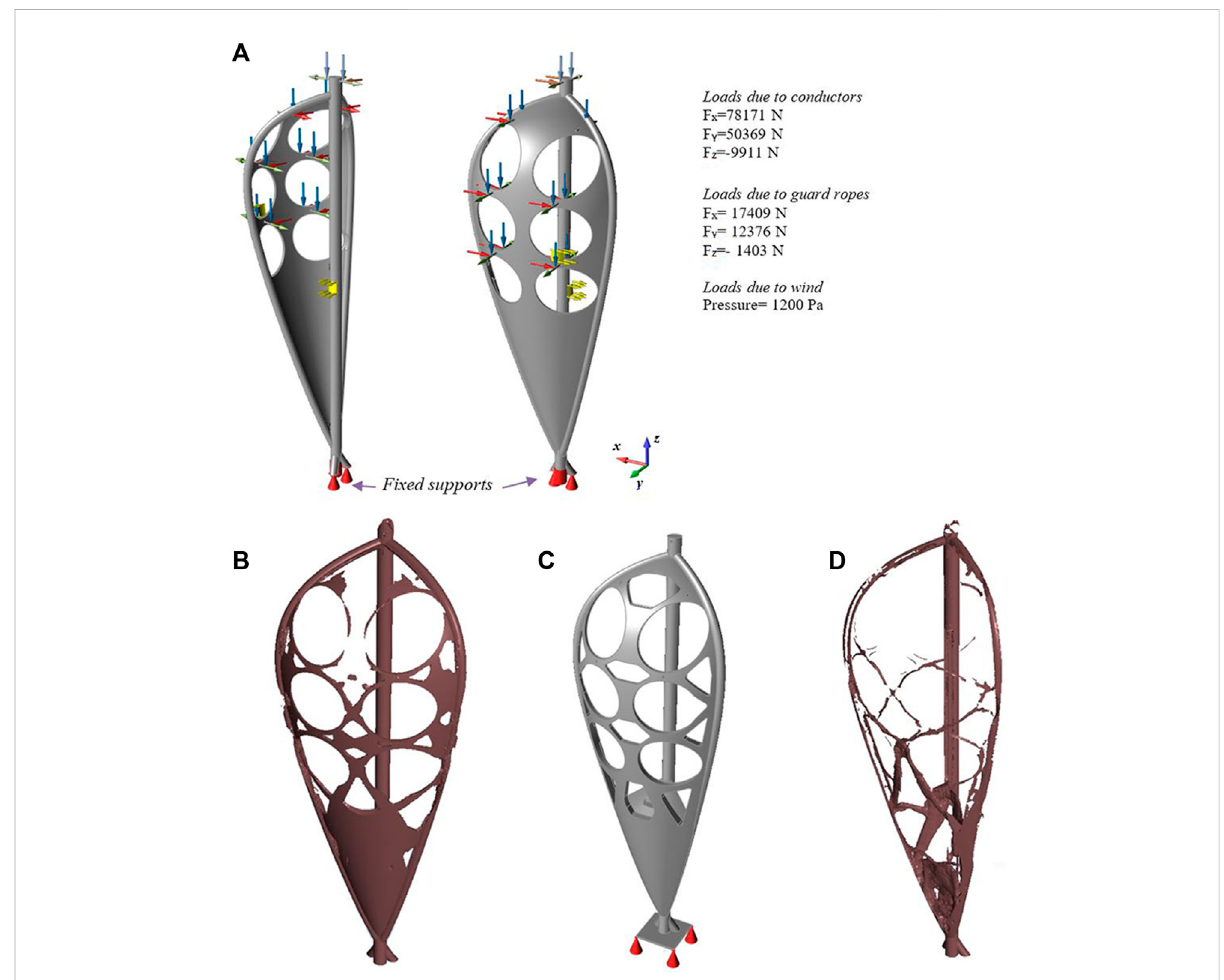
FIGURE 8 TOresults. (A) thegeometricmodel,theconstraints,andtheloadsforLC#2implementedinOptistruct ® ; (B) theresultsoftheTOperformedto remove about 60% of the material; (C) the new project space by simplifying those details dif fi cult to achieve in practice; (D) results of the fi nal